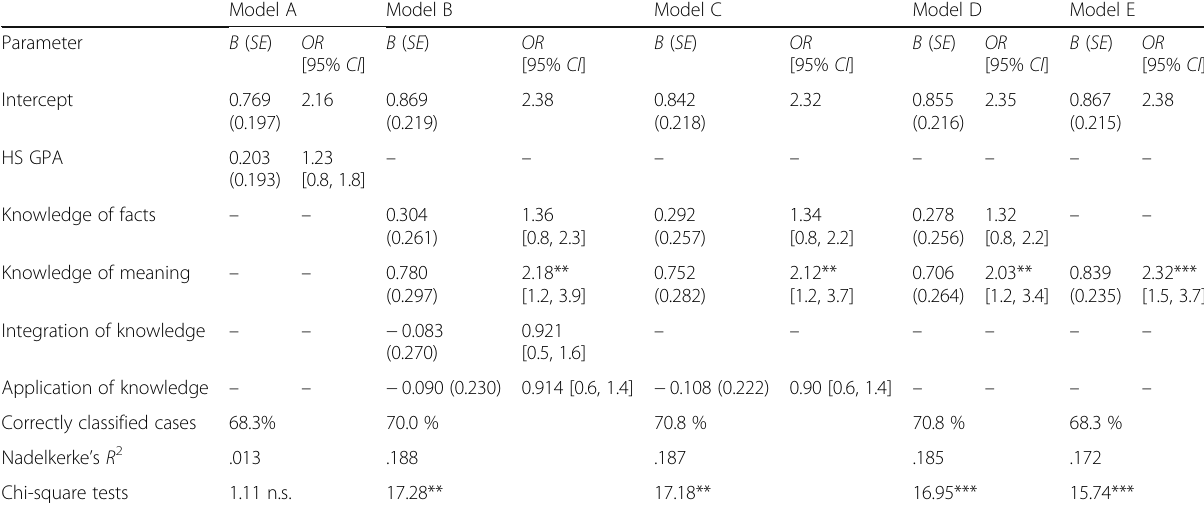
Table 2 Summary of the logistic regression analysis for academic achievement in biology